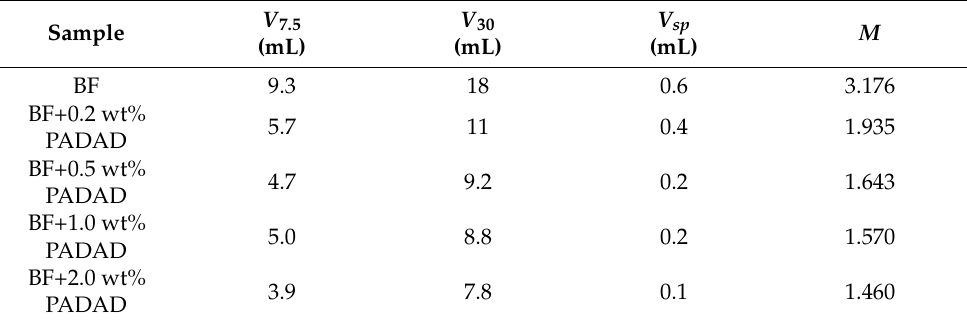
Figure 9. Fluid loss vs. time profiles of BF and BF/PADAD suspensions according to API procedures at 25 °C. Table 3. Change in V 7.5 , V 30 , V sp , and M of drilling fluid containing different concentrations of